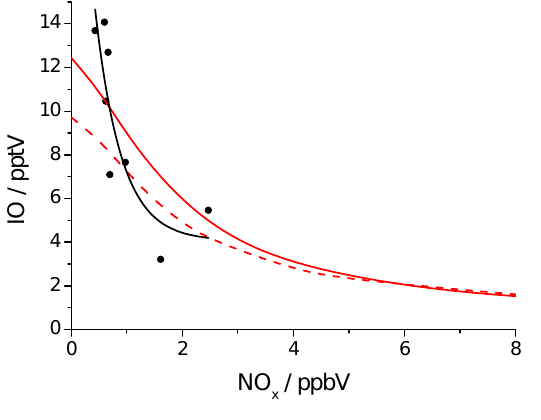
Fig. 8. The dependence of measured IO on NO x at peak [IO] (black circles). The graph shows how the measured peak [IO] (60 min average) varies with [NO x ] (60 min average, at the pe- riod of peak IO (30 min either side of peak IO)) for 8 days of the campaign when there was a clear IO diurnal (exponential de- cay fit, black line, [IO]=4.06+26.6 exp ( −[ NO x ] / 0 . 50 ) , R 2 =0.77). Model results show a similar IO dependence on NO x , [IO] at 50 s after t =0 s (solid red line) and [IO] at 60 s after t =0 s (dashed red line). Initialised with 100pptv I 2 . Exponential decay fits: [IO]=1.00+11.8exp ( −[ NO x ] / 2 . 40 ) , R 2 =0.997 ( t =50 s, solid red line), [IO]=0.98+9.02exp ( −[ NO x ] / 2 . 49 ) , R 2 =0.996 ( t =60 s, dashed red line).